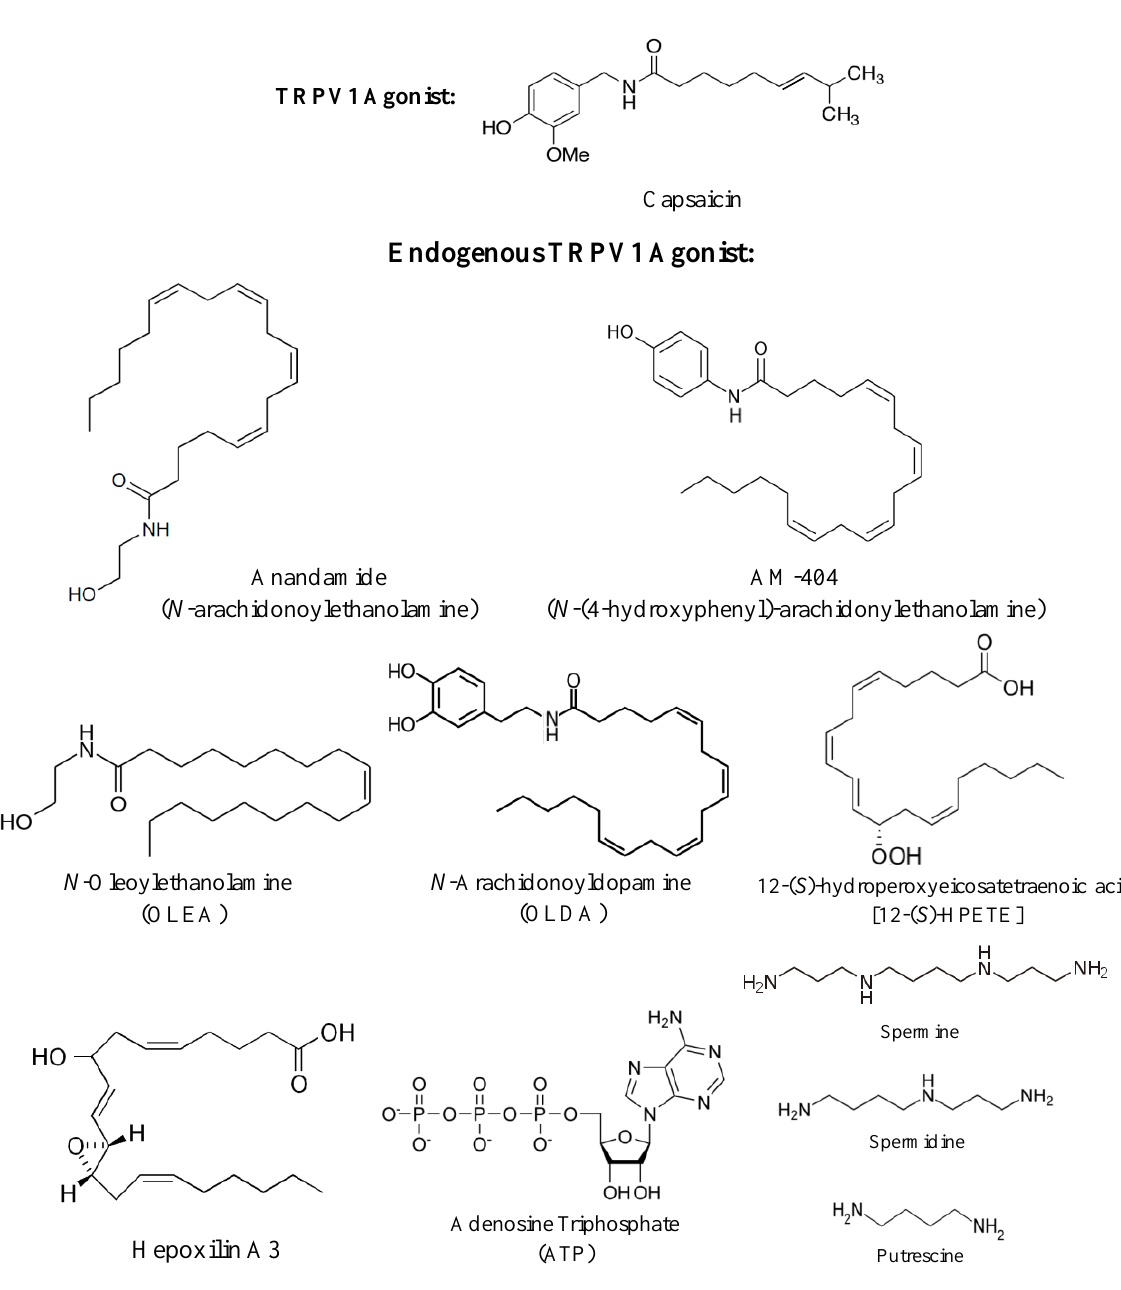
Figure 1. Chemical structures of natural and endogenous transient receptor potential vanilloid 1 (TRPV1) receptor